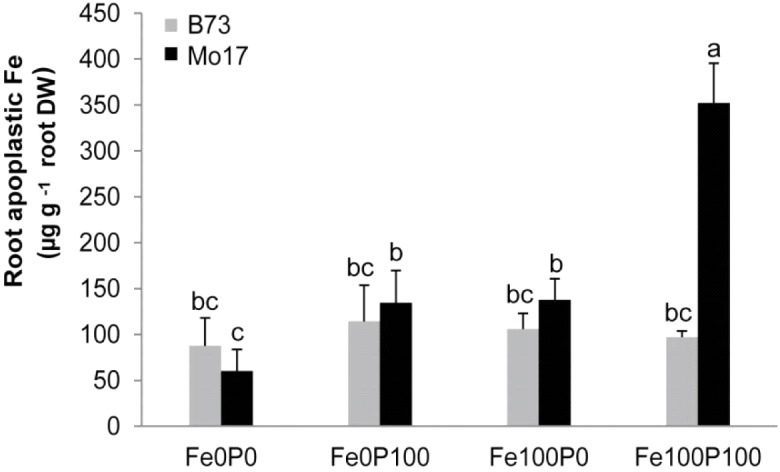
Accumulation of apoplastic Fe under concomitant P supply in the two maize genotypes B73 and Mo17. Plants were grown for 15 days in nutrient solution supplemented without Fe and P (Fe0P0), without Fe and with 100 μM P (Fe0P100), with 100 μM Fe and without P (Fe100P0), or with 100 μM Fe and 100 μM P (Fe100P100). Fe and P treatments were initiated after one week of preculture on full nutrient solution. Bars indicate mean values ± SD, n = 5. Different letters denote significant differences at p < 0.05.